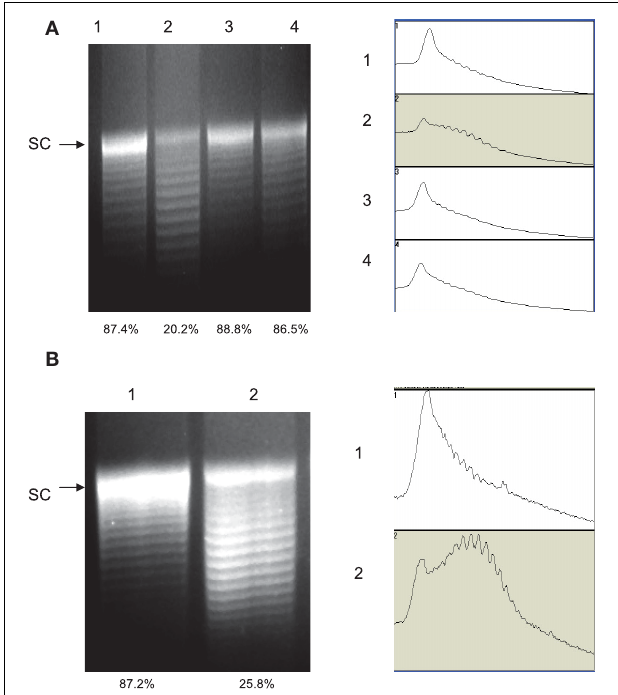
FIGURE 3 |Agarose gel electrophoresis analysis of plasmid topoisomers extracted from different strain background. The plasmid DNA was run on a 1.0% agarose gel containing 20 μ g/ml chloroquine. (A) Plasmid pRY107 isolated from strain S3B derivatives. Lane 1, pRY107 from 62301S; Lane 2, pRY107 from 62301R (carrying theThr-86-Ile mutation in GyrA); Lane 3, pRY107 from 52901-II2 (carrying theThr-86-Lys mutation in GyrA); and Lane 4, pRY107 from 62301R37 (carrying the Asp-90-Asn mutation in GyrA). (B) Plasmid pRY107 isolated from strain 11168 and its derivatives. Lane 1, pRY107 from NCTC 11168; and Lane 2, pRY107 from 11168CT (carrying theThr-86-Ile mutation in GyrA).The results of densitometric scanning are shown to the right of each gel image.The numbers on the left of the densitometric scanning correspond to the lane numbers of the gel image.The number below each lane indicates the percentage of the most supercoiled DNA in the total population of plasmid topoisomers as measured by